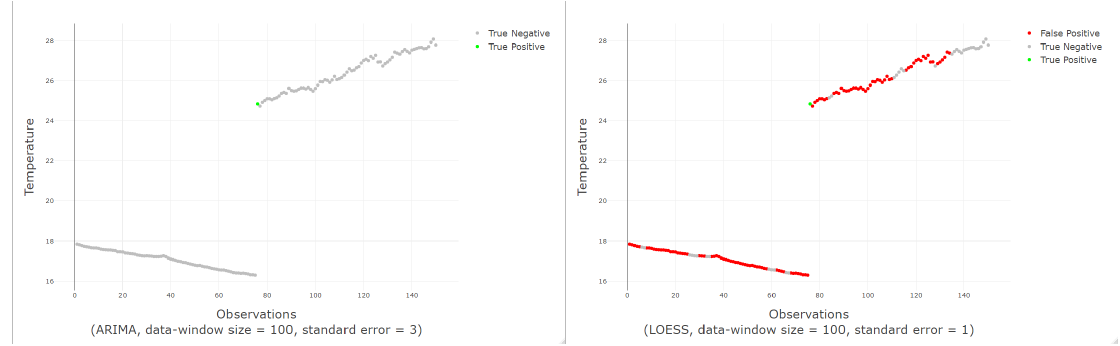
Figure 11. On the left, an example of a good classification; on the right, an example of a bad classification.